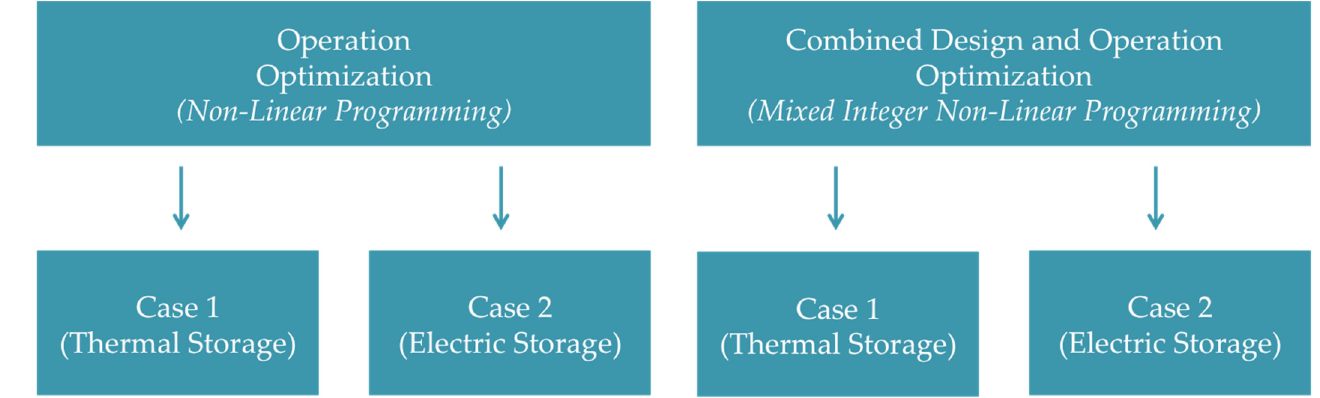
Figure 2. Recap of the cases analyzed and the methodologies adopted.